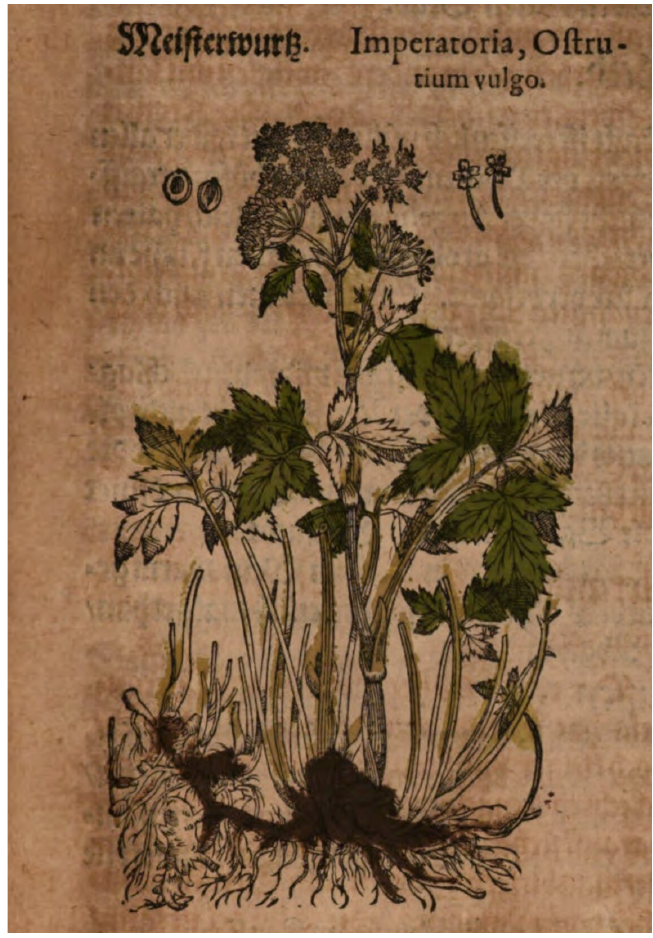
Figure 3. Masterwort in a colourised illustration from Pietro Andrea Mattioli’s De plantis epitome utilissima , published by Joachim Camerarius in 1611.